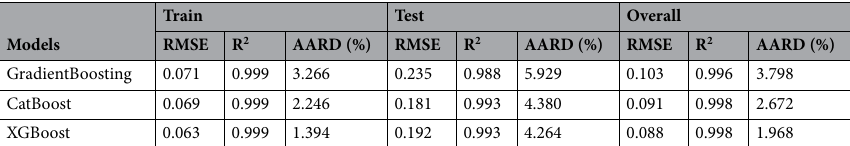
Table 3. Statistical indices used for describing the performance of proposed models.